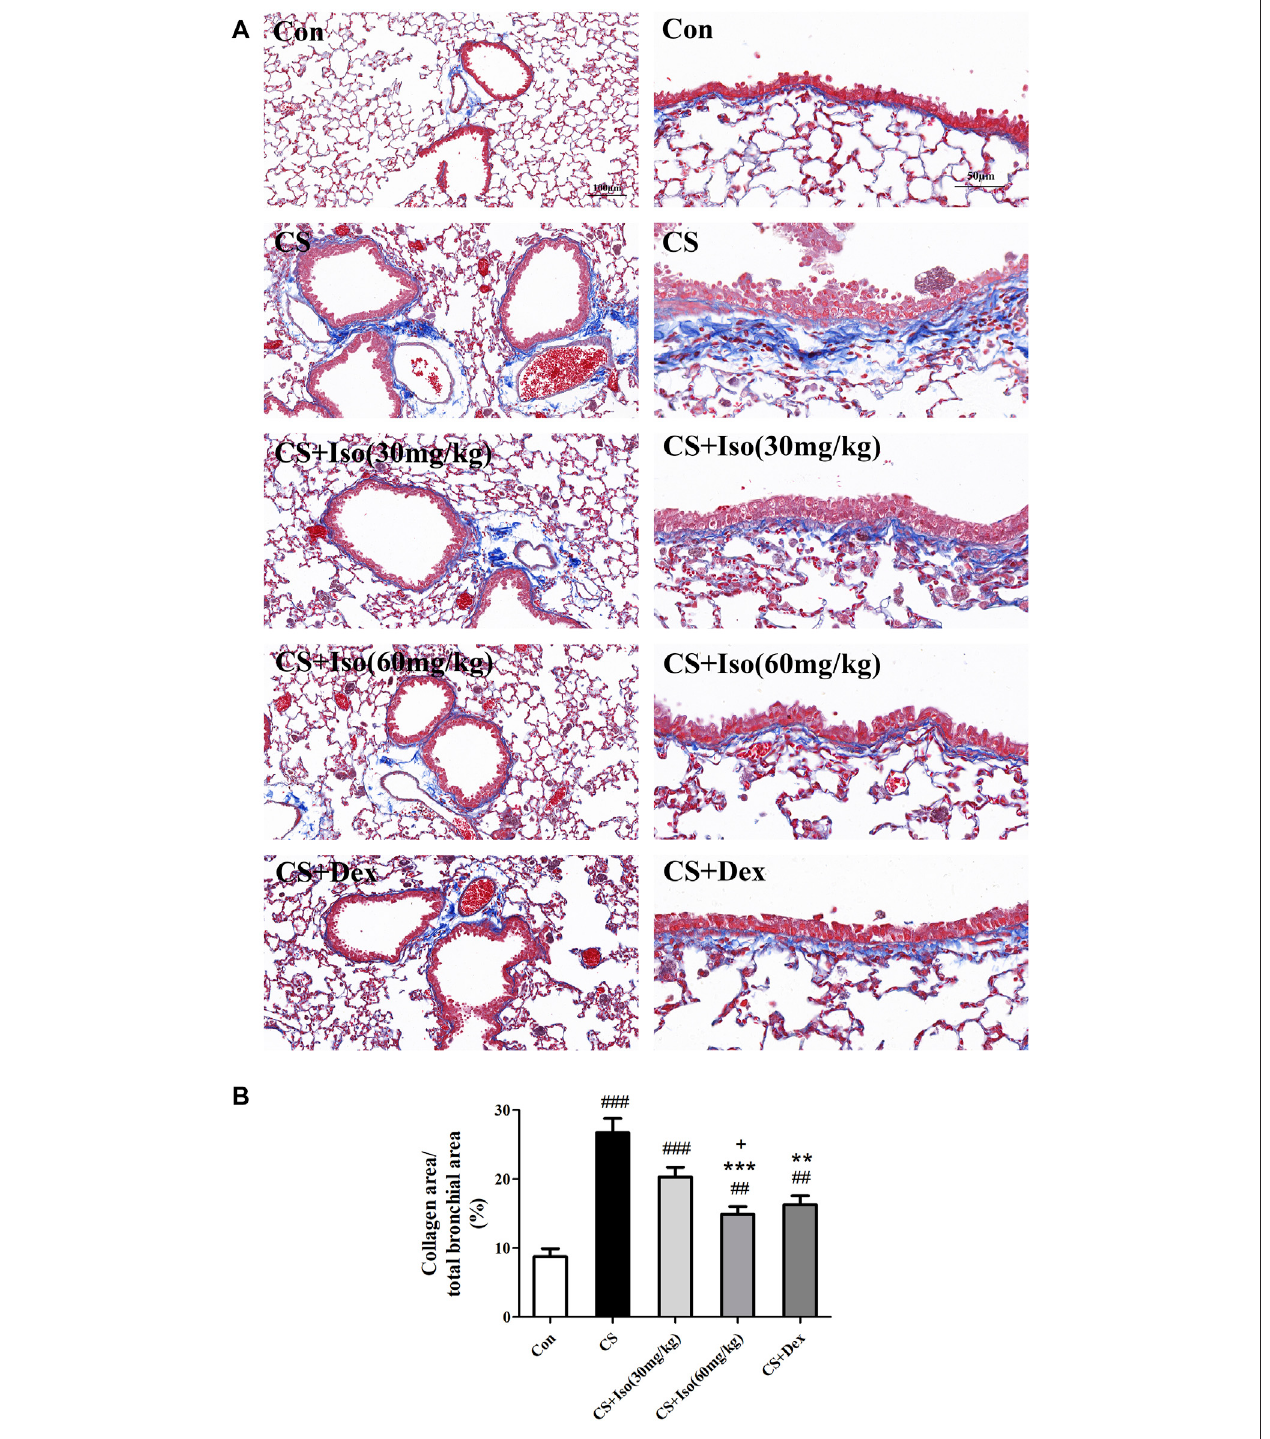
FIGURE 5 | Iso inhibits the collagen deposition induced by CS. Lung tissues were subjected to Masson staining. (A) Representative histopathological sections of collagen deposition (blue color) in lungs (scale bar 100 μ m/50 μ m). (B) Quantitative analysis of collagen deposition ( n = 5 mice per group). Data was shown as mean (±SD) (B) .Totestforgroupdifferencsesone-wayANOVA (B) wasapplied. ## p < 0.01, ### p < 0.001vs.controlgroupand** p < 0.01,*** p < 0.001vs.CSgroupand + p < 0.05 vs. CS + Iso 30 mg/kg